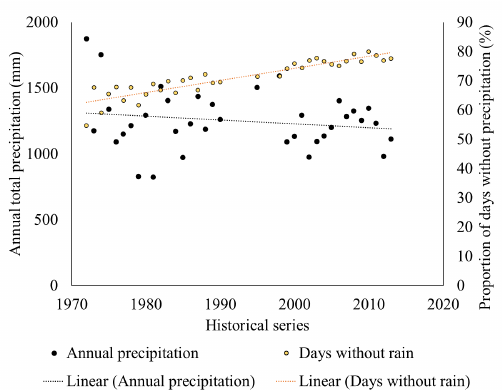
Figure 4. Total precipitation per year occurring in the Northern Pantanal from 1971 to 2013 – black dots; and the proportion of days without precipitation – yellow dots. The proportion was calculated by the variation in the numbers of days per years available in the data set.